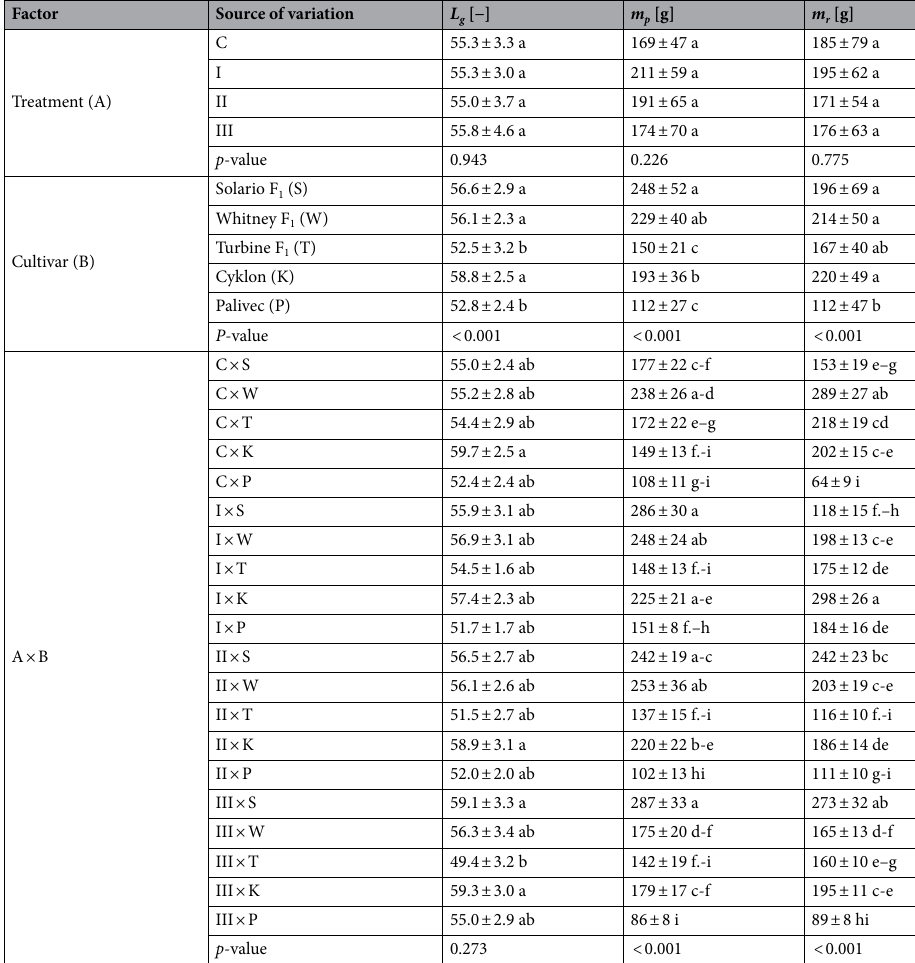
Table 1. Effect of the combined application of biostimulants on the biometric parameters (mean values ± standard deviations) of plants in the analyzed cultivars of Capsicum . Means followed by different letters are significantly different for each parameter (the level of significance, the p -value, is shown in the table). L g -leaf greenness (SPAD), m p -weight of aboveground plant parts, m r -root weight. C-control treatment; I-BB Foliar + Multical; II-BB Foliar + Multical + MK5; III-BB Foliar + Multical + MK5 + Biocin